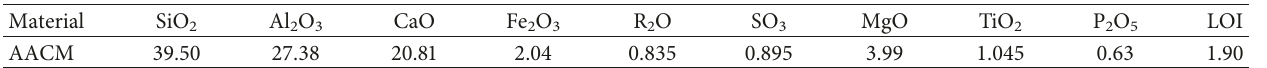
Table 4: Chemical composition of AACM.